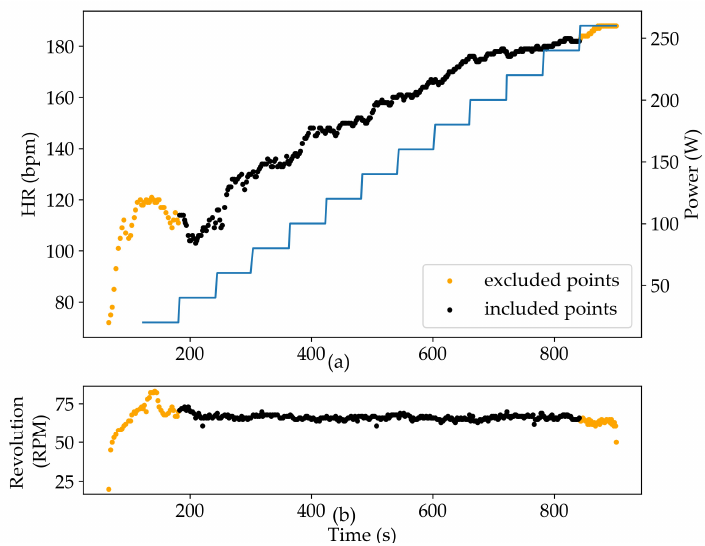
Figure 1. ( a ) Representative HR time series (bpm, black and orange dots) (subj #1) and the corre- sponding exercise intensity values (Watt, blue line). ( b ) Revolution time series (RPM, black and orange dots). Orange dots indicates workload increment intervals of the exercise that were excluded from the analysis.